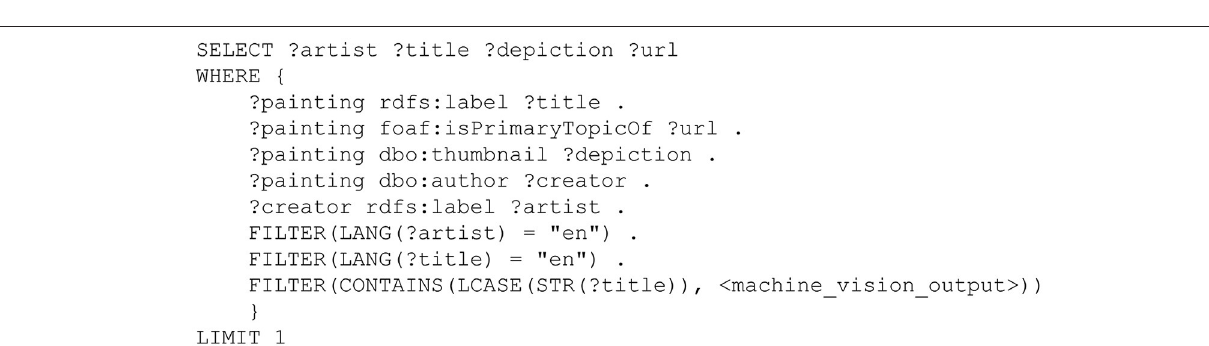
FIGURE 4 | An example query used in the context of the HoloArt app. This query executes against a machine-readable version of Wikipedia, called DBpedia. The query can be executed against DBpedia (http://dbpedia.org/sparql) by replacing the term <machine_vision_output> with the title of a painting (Note the title should be in lower case and enclosed by quotation marks, e.g., “oath of the